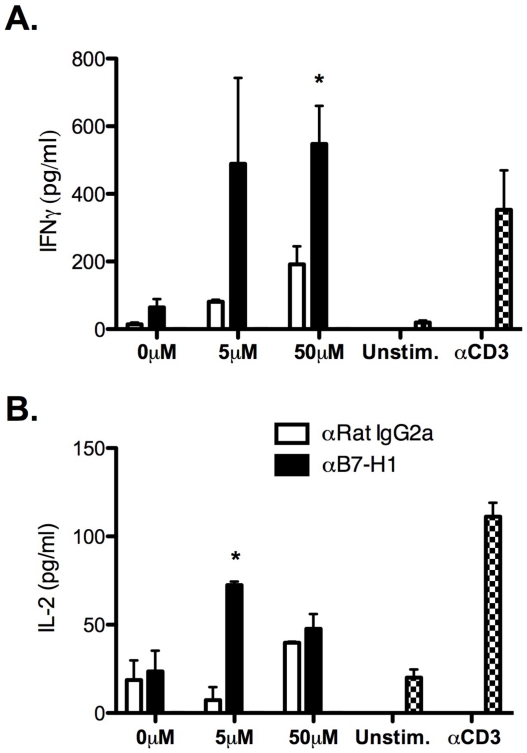
Blockade of B7-H1 enhances cytokine production from TMEV-specific CNS-infiltrating CD8+ T cells ex vivo.CNS (brain and spinal cord) mononuclear cells were isolated from TMEV-infected mice (n = 10/group) at day 7 post-infection and co-cultured in the presence of increasing concentrations of the CD8+ T cell restricted peptide-VP3159–66. Control Ig (open bars) and anti-mouse B7-H1 (black bars) were added to the cultures. Unstimulated and anti-mouse CD3-stimulated CNS mononuclear cells served as negative and positive controls, respectively. After 72 h, levels of IFN-γ (A), and IL-2 (B) were measured using CBA technology from the supernatants of triplicate wells. Data are representative of three separate experiments. *p<0.05 compared to cultures containing Rat IgG2a control.